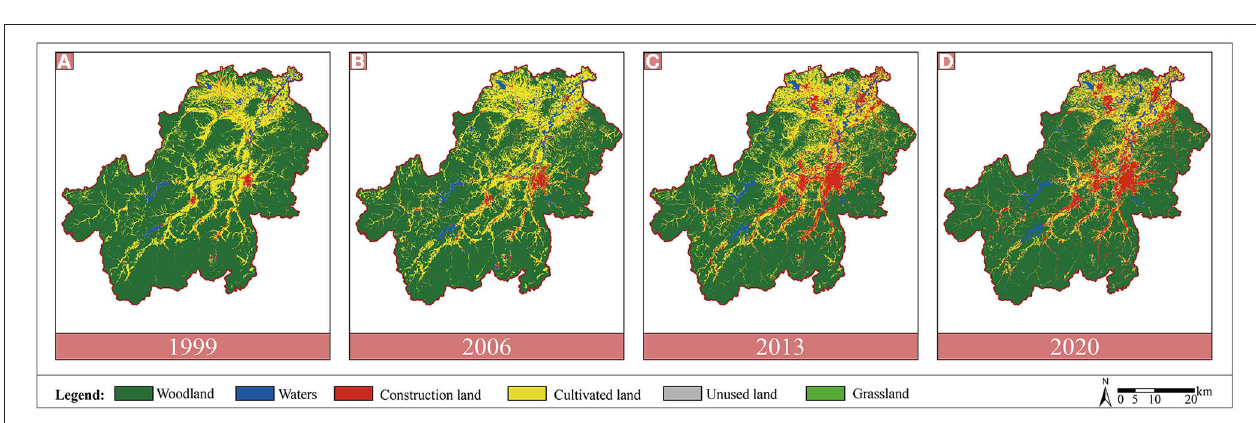
years. The detailed calculation methods used are presented in Supplementary Section 1.1